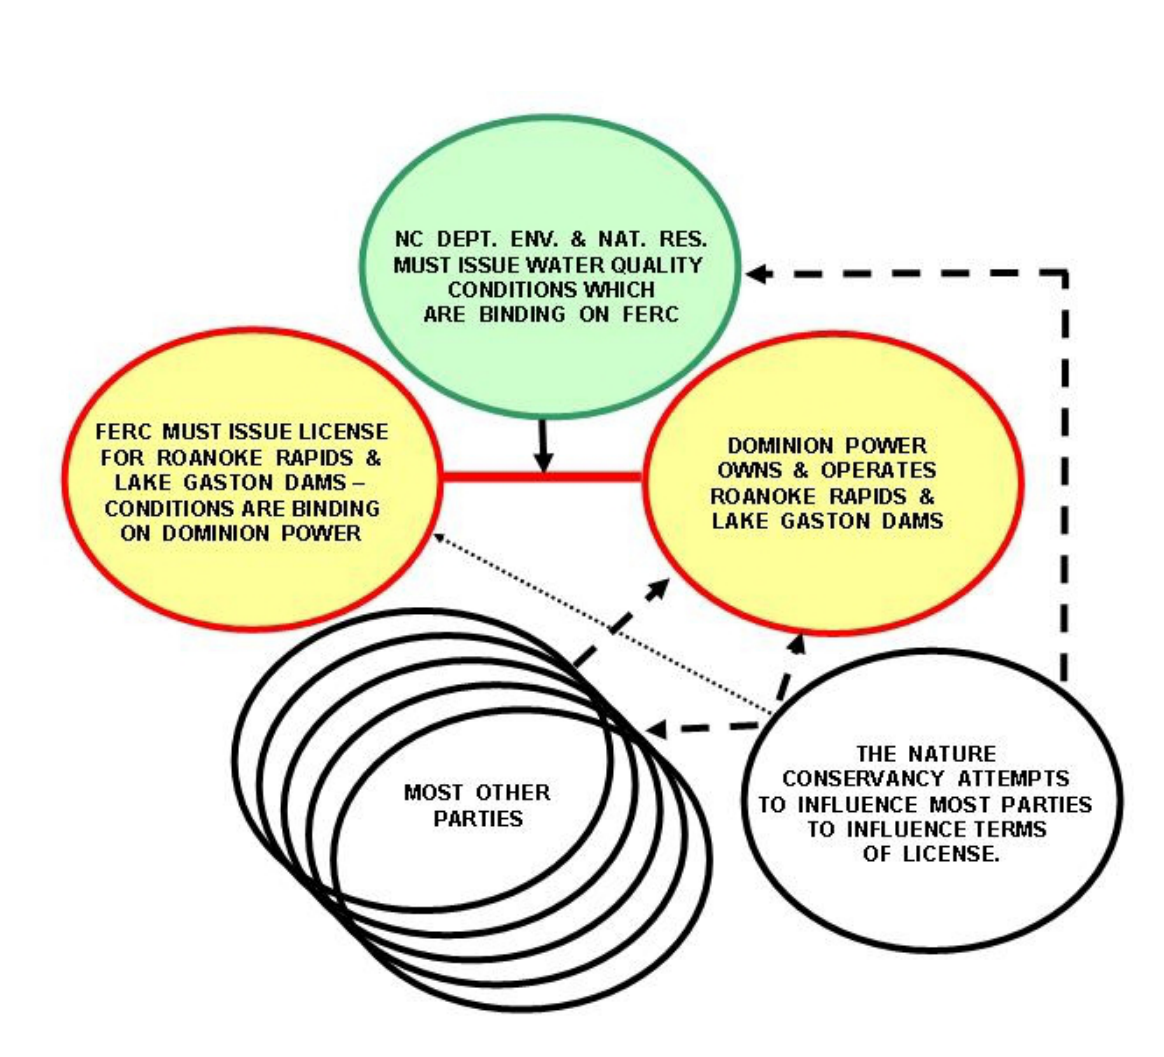
Fig. 5 . The Nature Conservancy